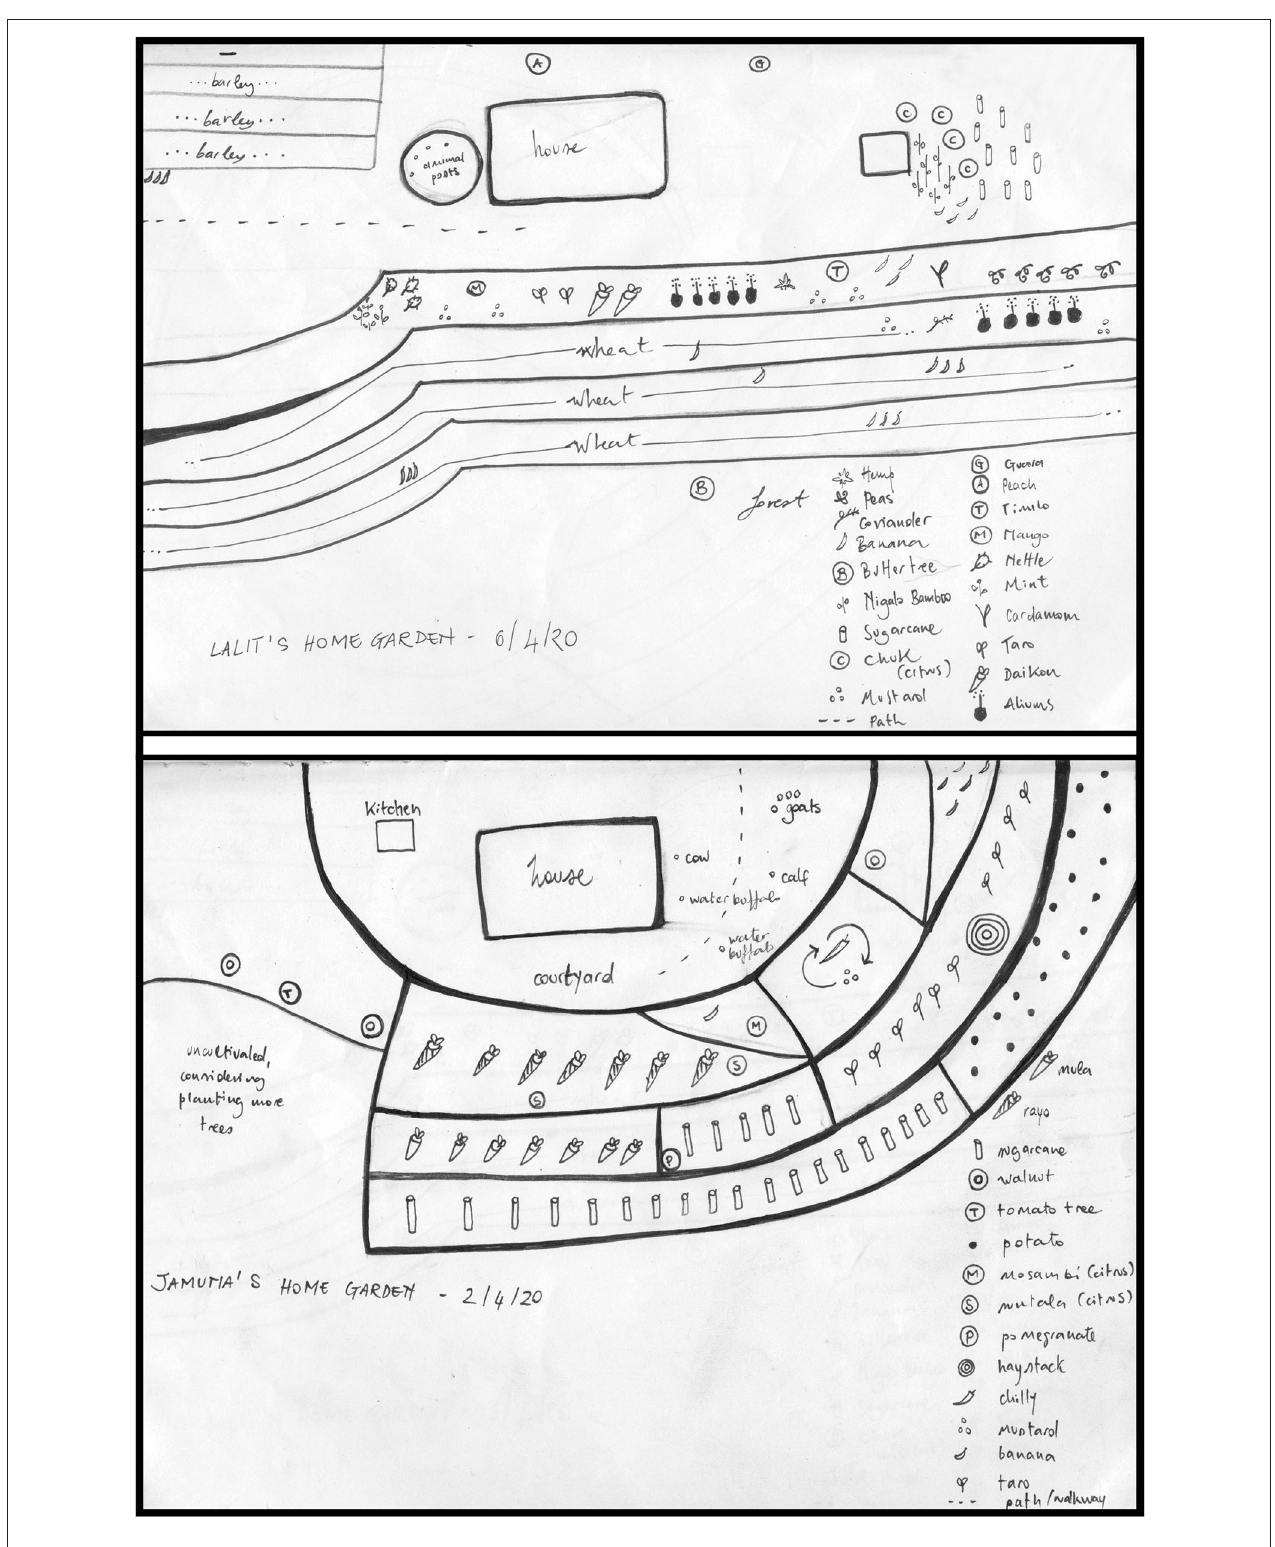
FIGURE 3 | Home garden